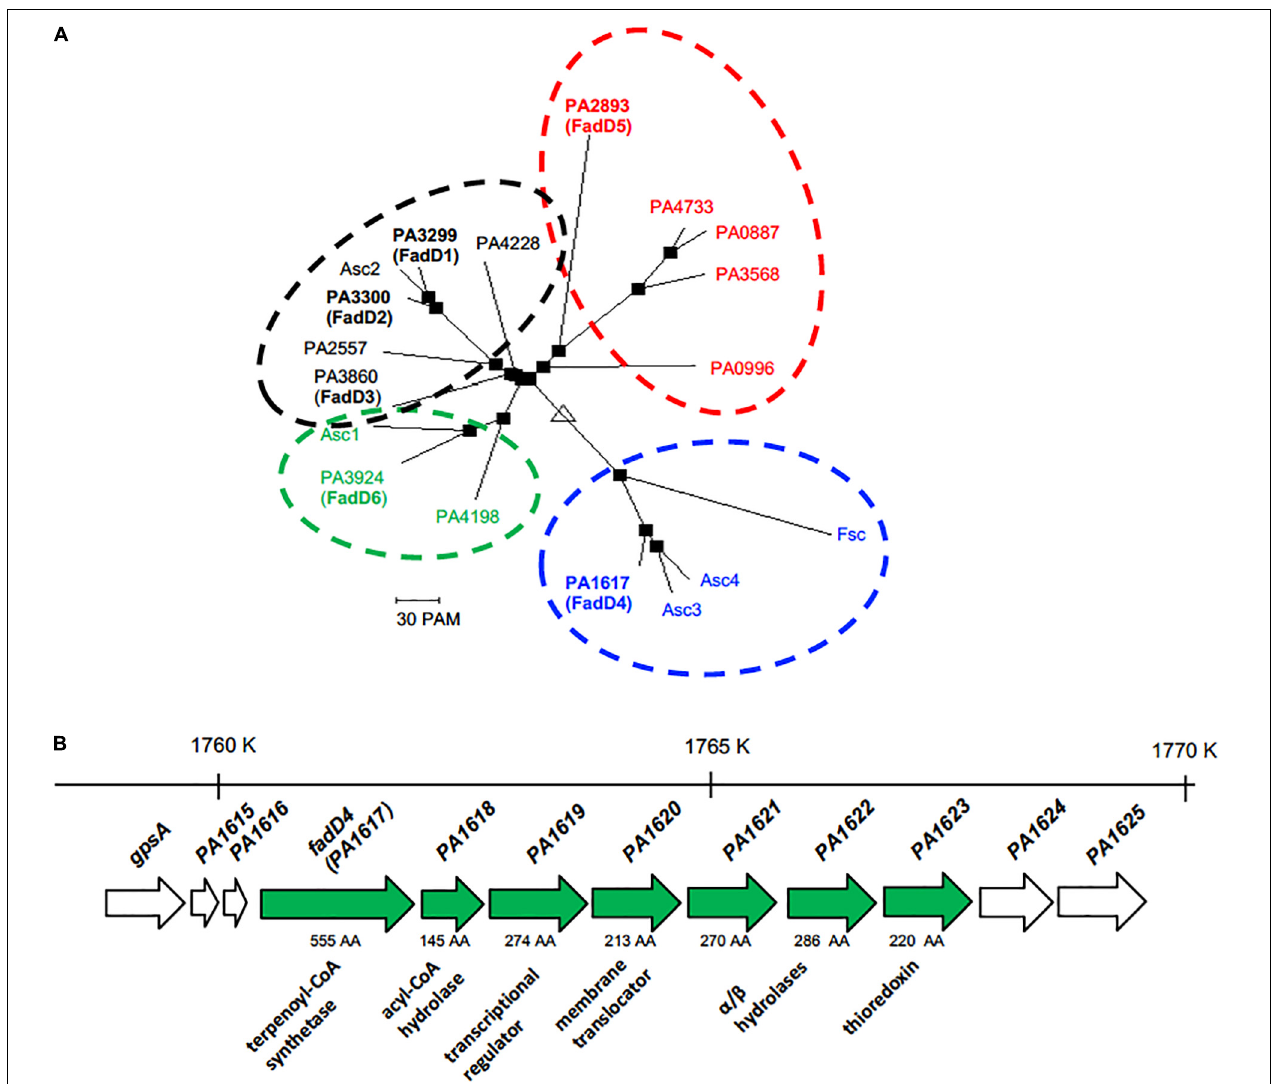
FIGURE 2 | Phylogenetic and genetic contexts of the PA1617 ORF in P. aeruginosa PAO1 genome. (A) Phylogeny tree of the alignment shown in Figure 1 . (B) Location of the PA1617 (FadD4) gene cluster in the P. aeruginosa PAO1 genome. The numbers and orientation of ORFs correspond to their locations in the PAO1 genome (http://www.pseudomonas.com). The genomic region is indicated with numbers above each gene cluster; the length of genes based on the number of amino acids is indicated with a number below the arrows. Solid arrows denote the genes corresponding to the cluster. The gene sizes on ORFs are not on the same